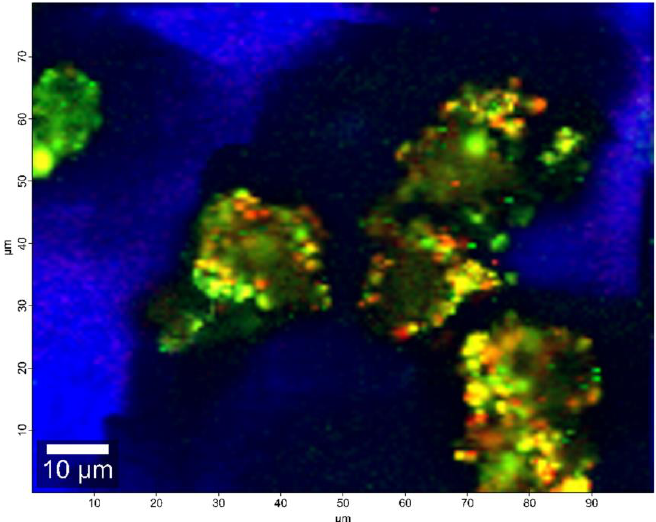
Figure 6. Raman surface distribution map of microparticle formulation M4: ZVD (red), gCS/CF matrix (green), ZVD- gCS/CF mixed regions (yellow), glass surface (blue).